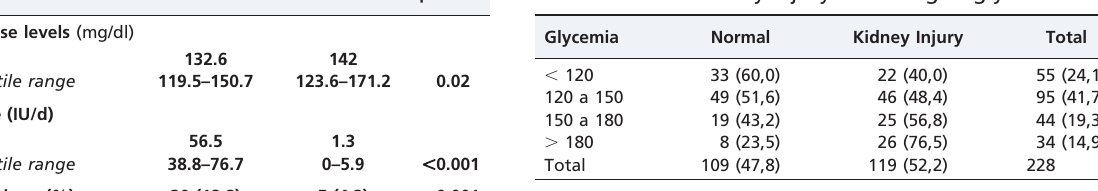
Table 4 - Acute kidney injury according to glycemic